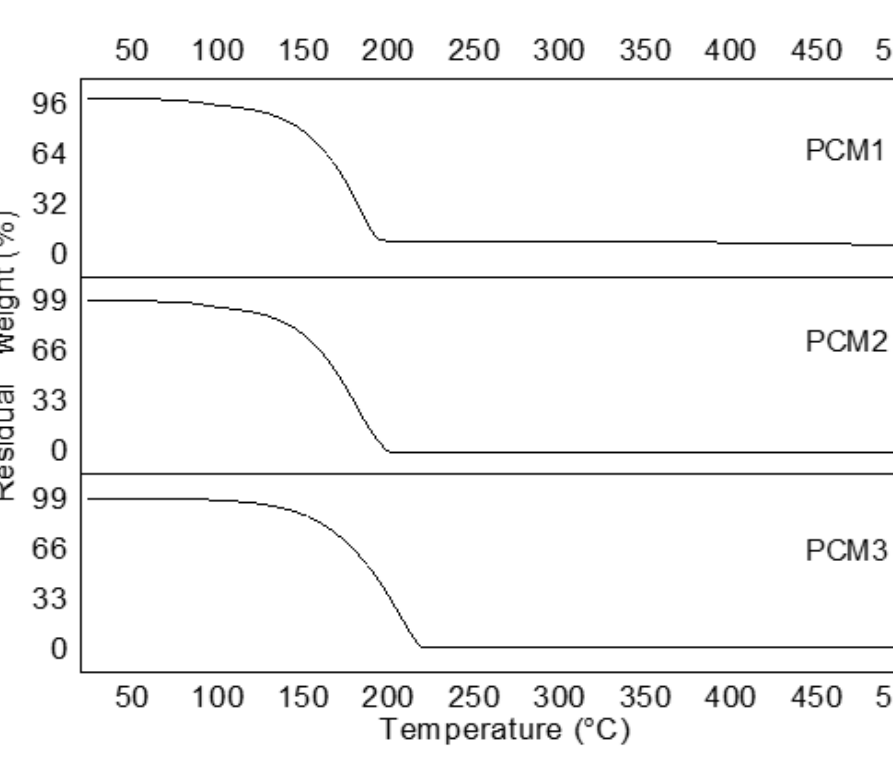
Figure 2. DTG curves of the PCM1-3.